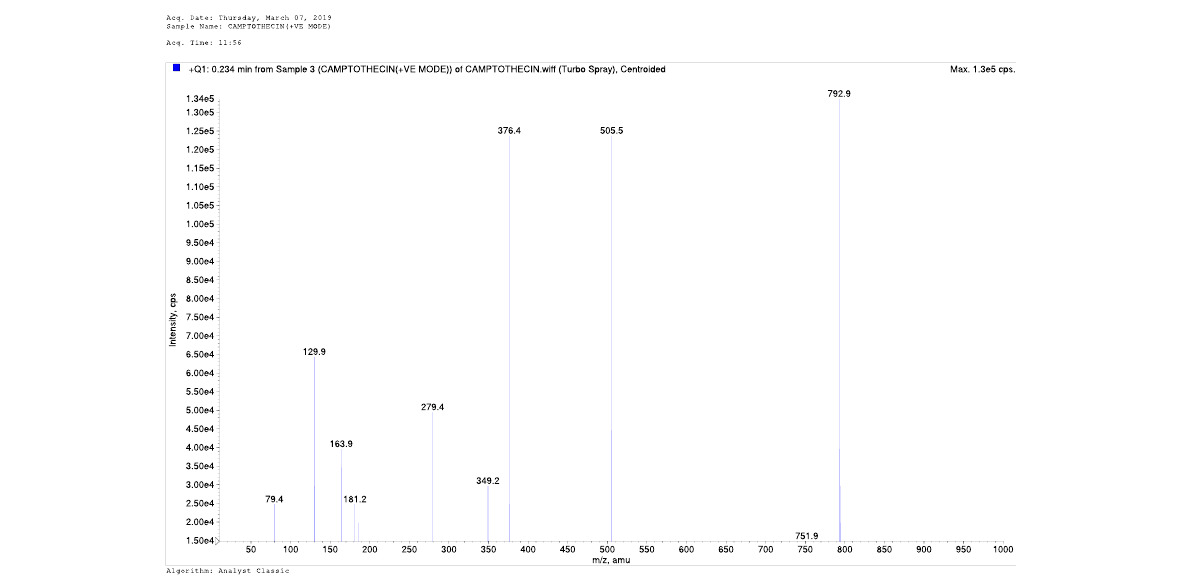
Fig. 2 Mass spectra of isolated